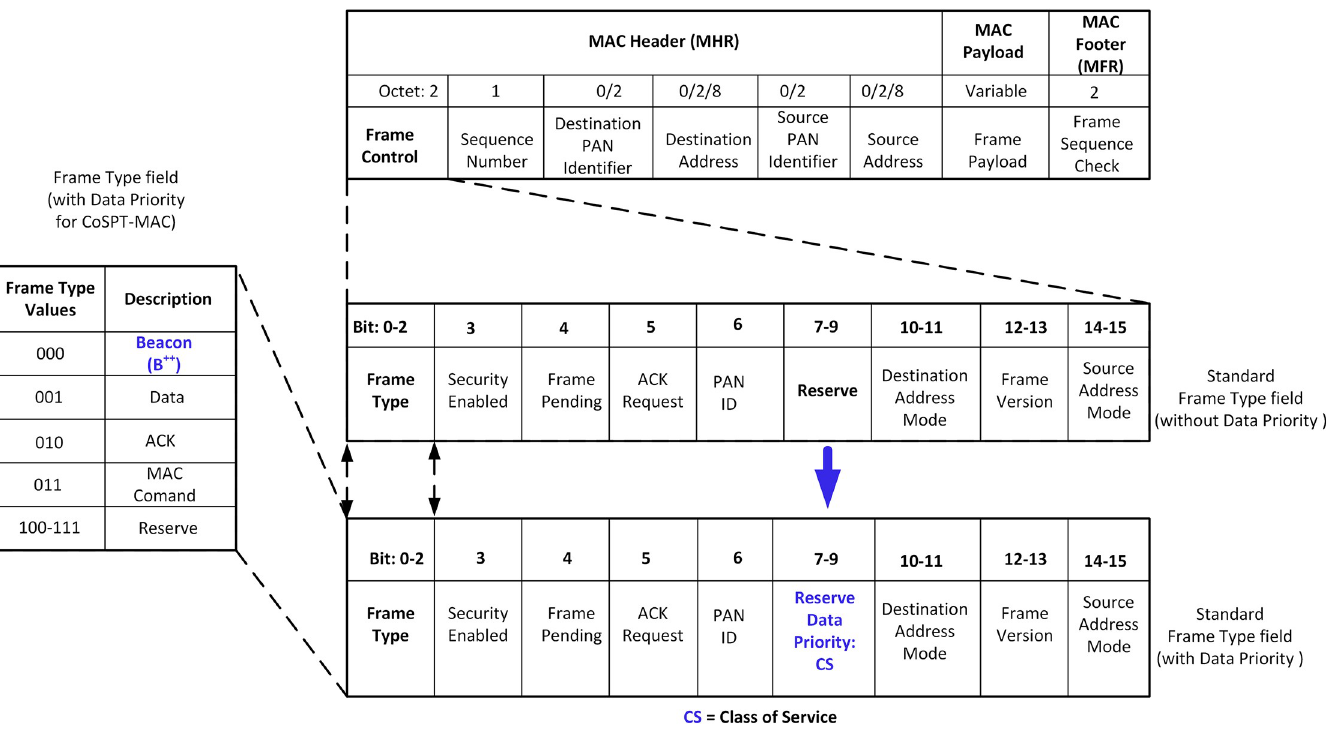
Fig 4. Modified IEEE 802.15.4 MAC frame format (with data priority for CSTP-MAC). https://doi.org/10.1371/journal.pone.0237154.g004 slotted beacon-enabled mode [9, 24]. In this mode, nodes randomly select BP or waiting time from the range of computed backoff time-slots using Eq 1, where 2 BE − 1 is known as the BEB algorithm. BE is bounded between BE {3,4,5}, where the minimum value of BE is 3 and its max- imum value is 5. Computing possible backoff range with these limits BE = 3,4 and 5 will give a